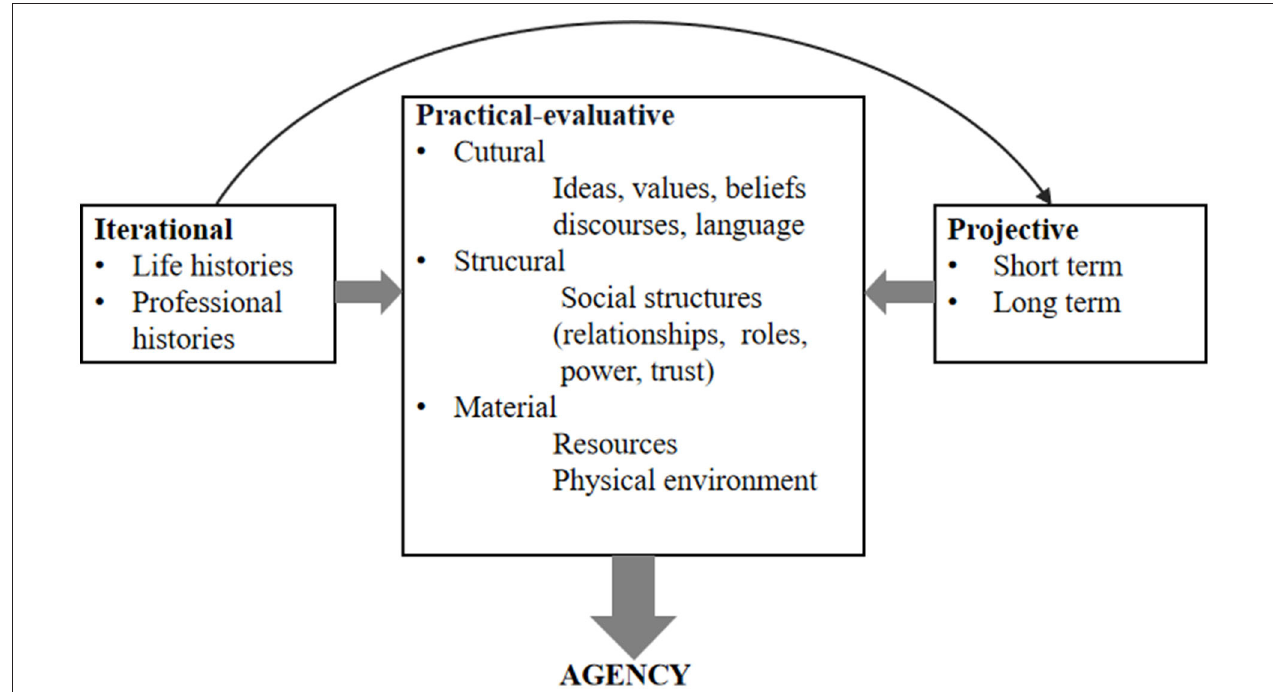
FIGURE 1 | Model of the formation of agency. Redrawn from Priestley et al. (2015), with permission from Bloomsbury Academic through PLS